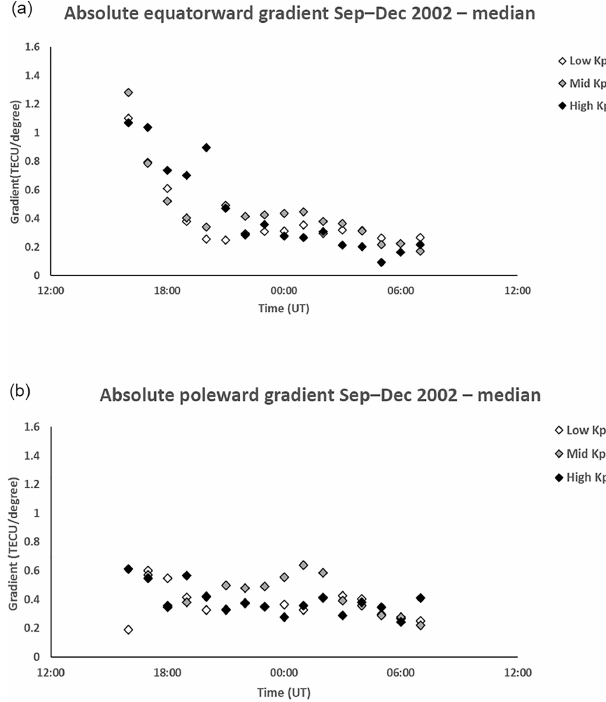
Figure 9. (a) Median latitude of the maximum VTEC on the pole- ward side of the trough from 16:00 to 07:00UT for low Kp (0 to 2 + ) , medium Kp (3 − to 4) and high Kp ( ≥ 4 + ) . The representative interquartile range is approximately 2.0 ◦ . The poleward maximum moves equatorward during the course of the night, with the location for the high geomagnetic activity being at the lowest latitudes but increasing near dawn. (b) Median of the maximum VTEC on the poleward side of the trough from 16:00 to 07:00UT for low Kp (0 to 2 + ) , medium Kp (3 − to 4) and high Kp ( ≥ 4 + ) . The represen- tative interquartile range is approximately 5.0 TECU. The VTEC decreases from in excess of 12 TECU at 19:00UT to about 8 TECU at